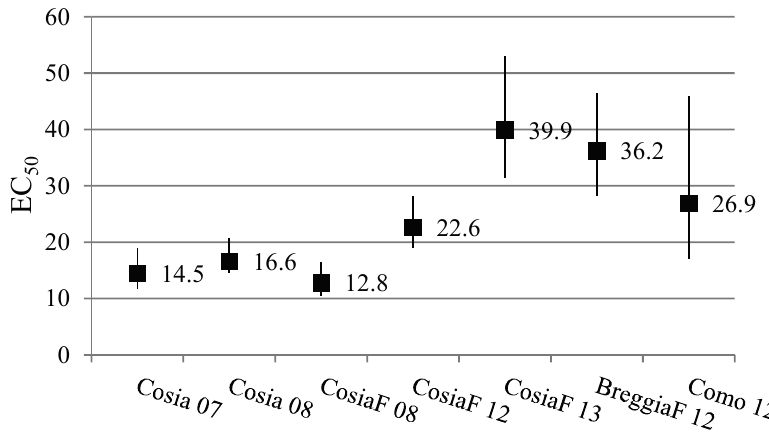
Figure 2. Daphnia magna acute EC ECs refer to the concentration